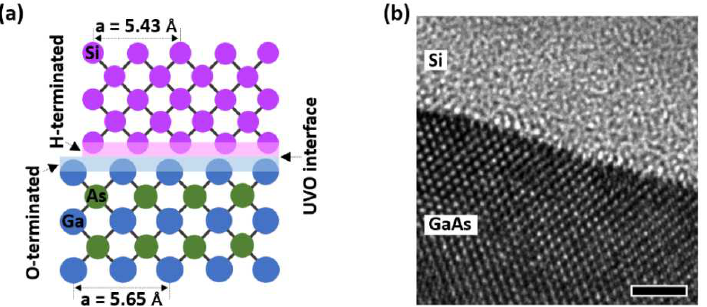
Figure 1. Atomic-scale features of the ultraviolet/ozone (UV/O 3 , UVO)-treated Si/GaAs heterojunction. ( a ) Schematic of the crystalline property of the Si/GaAs interface, in which the hydrogen (H)-terminated diamond cubic Si and oxygen (O)-terminated zinc blende GaAs are interfaced with the UVO-treated surface. a denotes the lattice constant. ( b ) Scanning transmission electron microscopy image of the Si/GaAs heterostructure formed by nanomembrane (NM) transfer printing with UVO treatment (Scale bar = 2 nm). The thickness of the interlayer was not quantified due to the presence of substrate